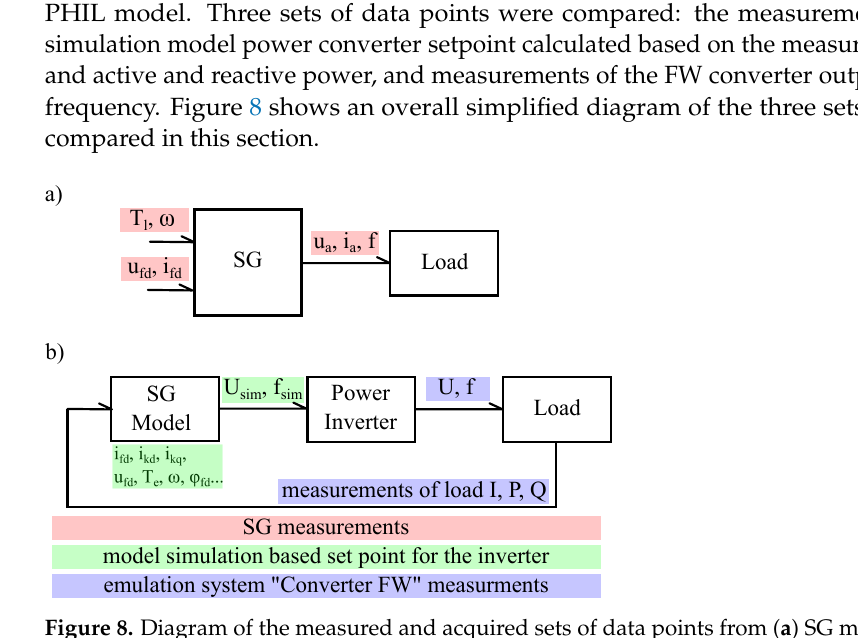
Figure 8. Diagram of the measured and acquired sets of data points from ( a ) SG measurements and ( b ) the emulation